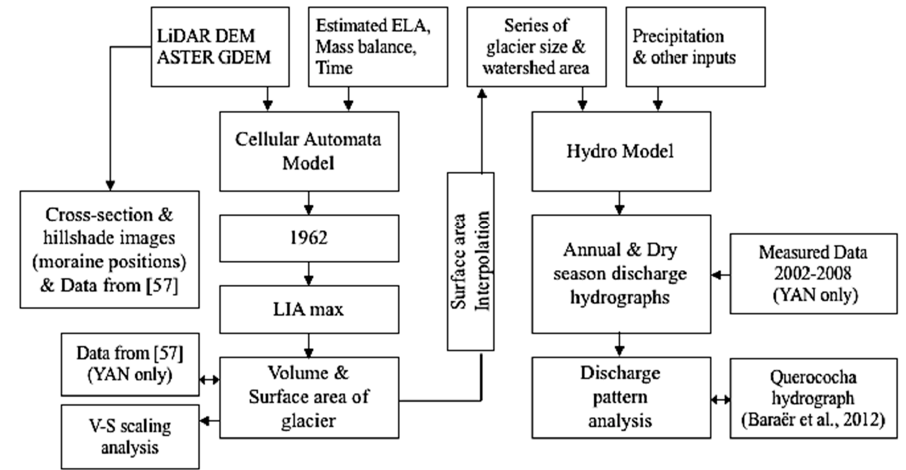
Figure 3. Schematic overview of cellular automata model [58] with hydro balance model [1] used for this